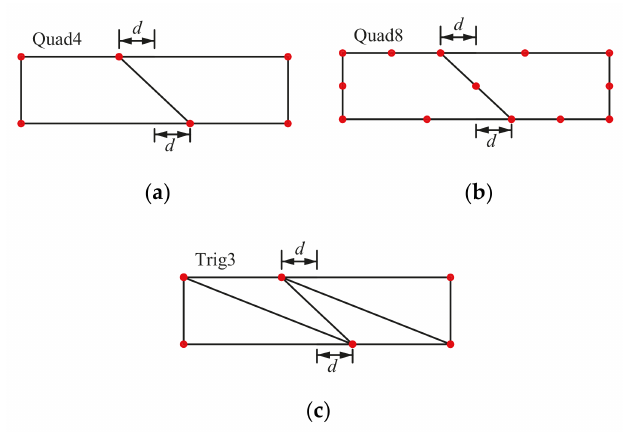
Figure 13. The mesh used for the distortion sensitivity test: ( a ) Mesh A; ( b ) Mesh B; ( c ) Mesh C. Table 3 lists the fundamental natural frequency assessed by different numerical